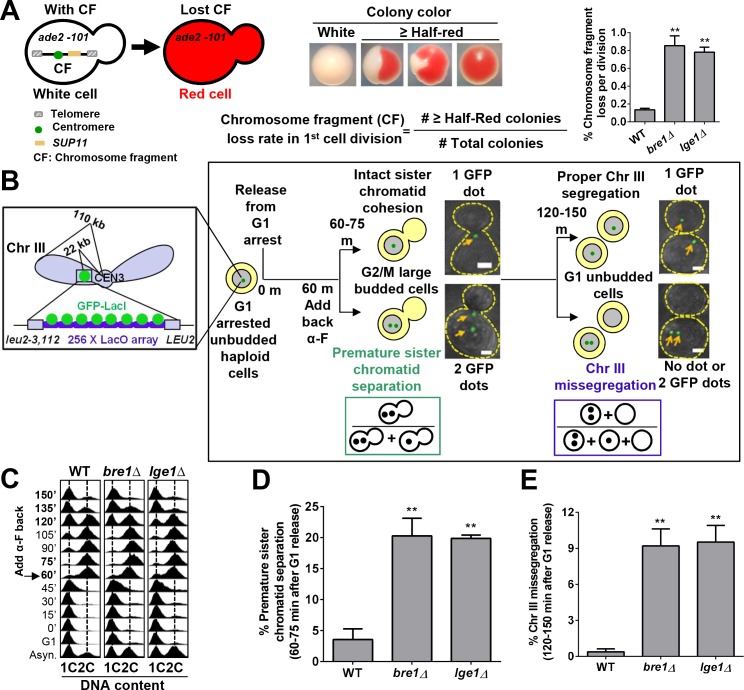
The E3 ubiquitin ligase Bre1 and its interacting protein Lge1 are required for accurate chromosome segregation and sister chromatid cohesion.(A) Chromosome transmission fidelity (CTF) phenotype was evaluated by the colony color-sectoring assay. Chromosome fragment (CF) loss rates in the first cell division in wild-type (WT), bre1Δ and lge1Δ were quantified by the number of half-red and more than half-red colonies divided by the total number of colonies. At least 2000 cells were scored in each experiment. The data shown represent the average of three independent experiments. Error bars, standard errors of the mean (SEM). Statistical significance was calculated by Student's t-test. Significant differences with WT are indicated by asterisks (**p<0.01). (B) Schematic diagram and flowchart of the sister chromatid cohesion assay and chromosome segregation assay examining GFP–Lac repressor (GFP–LacI) binding to Lac operator (LacO) integrated at 22 kb from centromere 3 (CEN3). MATa haploid yeast cells containing LacO and GFP–LacI in early log phase were arrested in G1 with alpha factor (α-F) and then released into YPD medium. α-F was added back at 60 min after release from G1 arrest to re-arrest cells at G1 phase in the next cell cycle. Samples were collected every 15 min for fluorescence-activated cell-sorting (FACS) analysis of DNA content and GFP fluorescence imaging. Representative fluorescent and bright field images were superimposed. Scale bar, 1 µm. Cells at 60–75 min after release from G1 arrest had large buds, and FACS showed that they were at G2/M phase. Sister chromatid cohesion was assessed. If sister chromatids had cohesion, only one GFP focus was observed. If they prematurely separated, two GFP foci were observed. The frequency of sister chromatid premature separation was calculated by the number of G2/M cells containing two GFP foci divided by the total number of G2/M cells. Most of the cells at 120–150 min after release from G1 arrest had no bud, suggesting that they had completed cytokinesis. They were assessed for chromosome segregation. Cells with more or less than one GFP focus had missegregated Chromosome III (ChrIII). The ratio of ChrIII missegregation was calculated by the number of G1 cells containing no GFP focus and two GFP foci divided by the total number of unbudded G1 cells. (C) Cell cycle progression of WT, bre1Δ and lge1Δ used in Figure 1B. Cells were arrested in G1 by alpha-factor (α-F) for 3 hr. Cells were washed and released into YPD medium. α-F was added back to the culture at 60 min post G1 release to restrict cells at G1 in the next cell cycle. Samples were collected every 15 min, and stained with propidium iodide for FACS analyses. (D) Frequency of sister chromatid premature separation in large budded cells at 60–75 min after release from G1 arrest in WT, bre1Δ and lge1Δ strains. At least 100 cells were scored for each sample. The data shown represent the average of three independent experiments. Error bars, SEM. Statistical analysis was performed using Student's t-test. Asterisks indicate significant differences from WT (**p<0.01). (E) Frequency of ChrIII missegregation in unbudded cells at 120–150 min after release from G1 arrest in WT, bre1Δ and lge1Δ strains. At least 100 cells were scored for each sample. The data shown represent the average of three independent experiments. Error bars, SEM. Statistical analysis was performed using Student's t-test. Asterisks indicate significant differences from WT (**p<0.01).